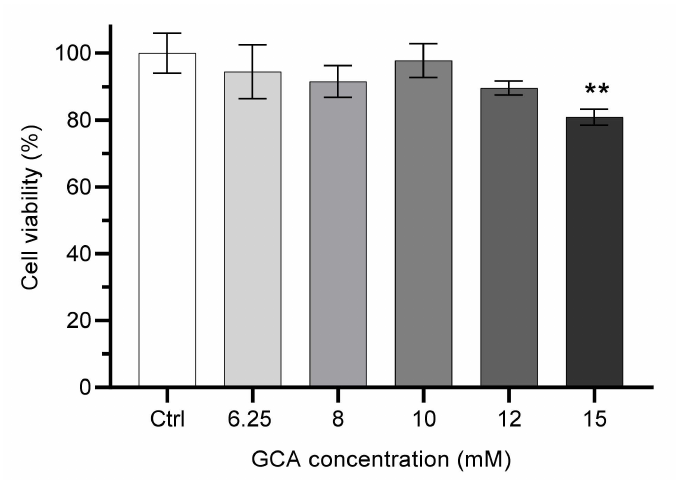
Figure 1. Effect of the concentration of bile salt GCA on Caco-2 cells viability. Cells were incubated with distinct GCA concentrations for 6 h. The GCA solutions were diluted with HBSS. Control cells were incubated in HBSS (100% viability). Statistically significant differences between the negative control are represented as ** p < 0.01, n ≥